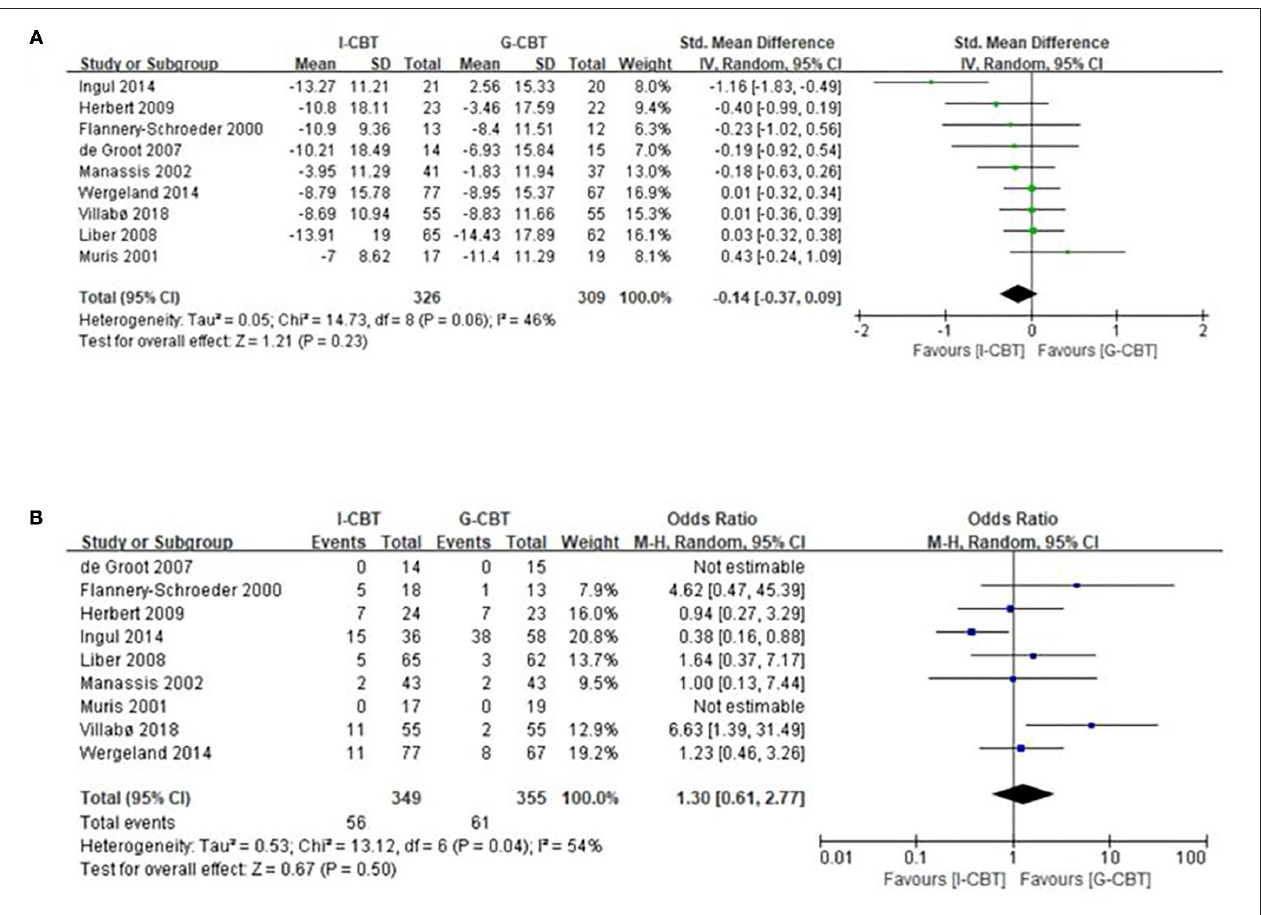
FIGURE 2 | Meta-analysis of primary efficacy outcome. (A) Forest plot of standardized mean difference (SMD) for changed scores in anxiety disorder rating scales in the comparison between individual cognitive behavior therapy (I-CBT) and group cognitive behavior therapy (G-CBT). (B) Forest plot of odds ratios (with 95% confidence intervals) of discontinuance for any reason in the comparison between I-CBT and G-CBT.